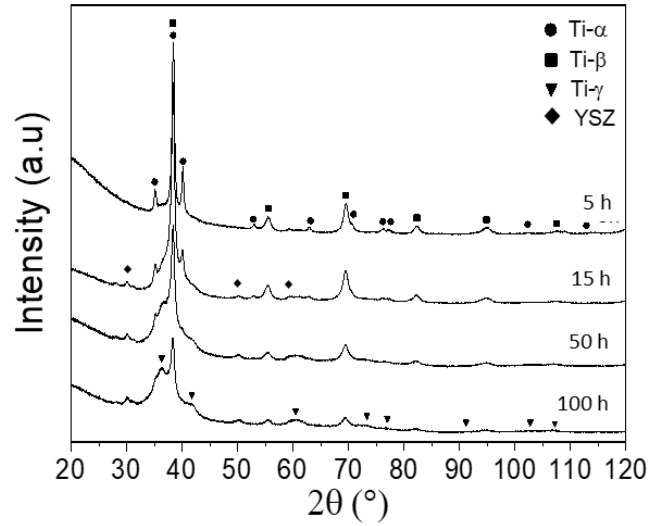
Figure 1. Evolution of XRD pattern as a function of milling time for Ti-13Ta-3Sn (at.%). Table 1. Microstructural parameter as a function of milling time for Ti-13Ta-3Sn (at.%). β -Ti Solid Solution Milling time, h